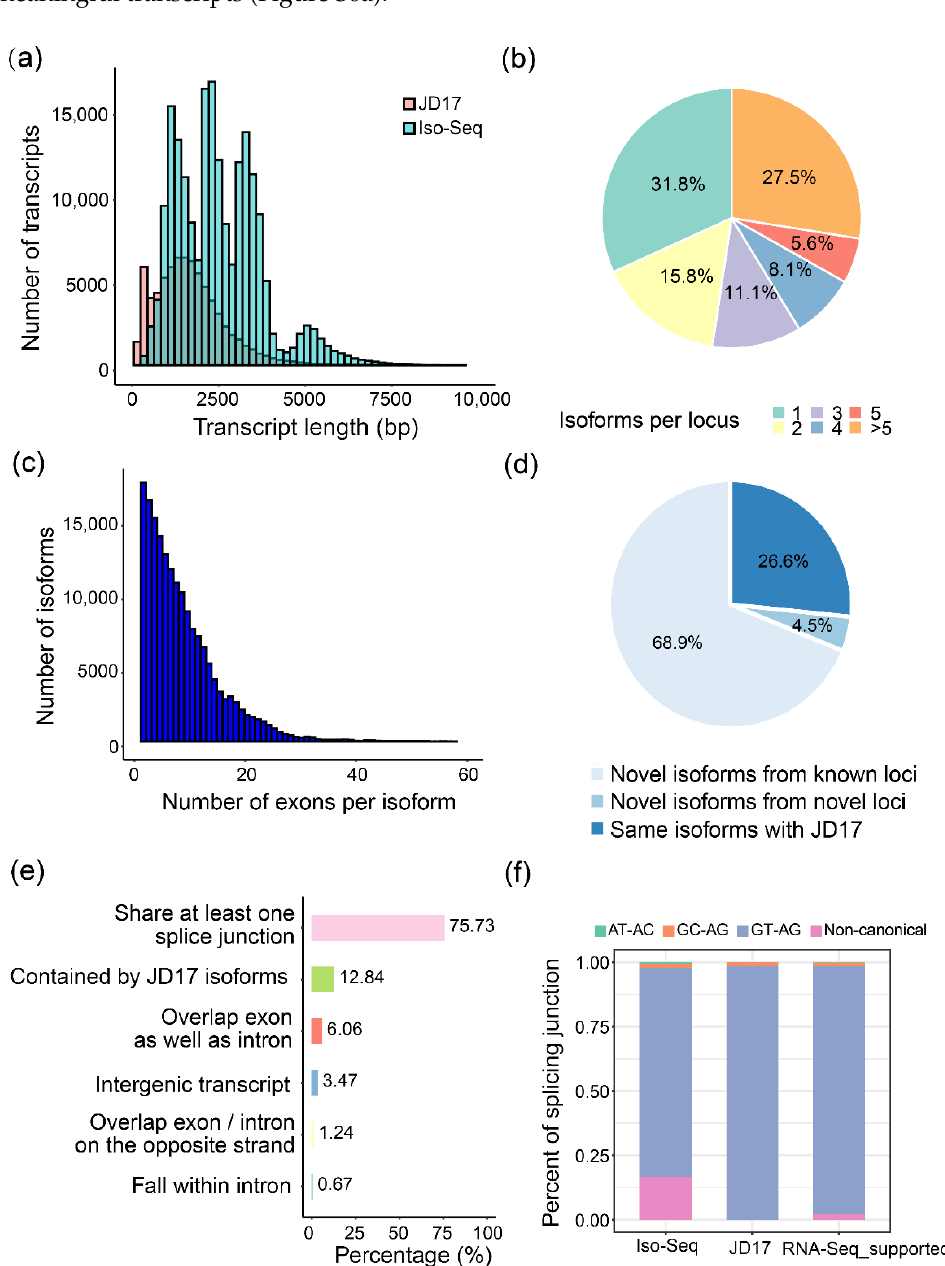
Figure 1. Summary of the Iso-Seq data. ( a ) The distribution of transcripts length for Glycine max cv. Jidou 17 (JD17) reference (pink) and Iso-Seq data (green); ( b ) Pie chart for the percentage of isoform numbers per locus; ( c ) Number of exons per transcript for the Iso-Seq transcripts; ( d , e ) Composition of the Iso-Seq isoforms relative to the JD17 reference ( d ) and detailed categories of novel isoforms compared to the JD17 reference ( e ); ( f ) Splicing junctions of the Iso-Seq data versus the JD17 reference.